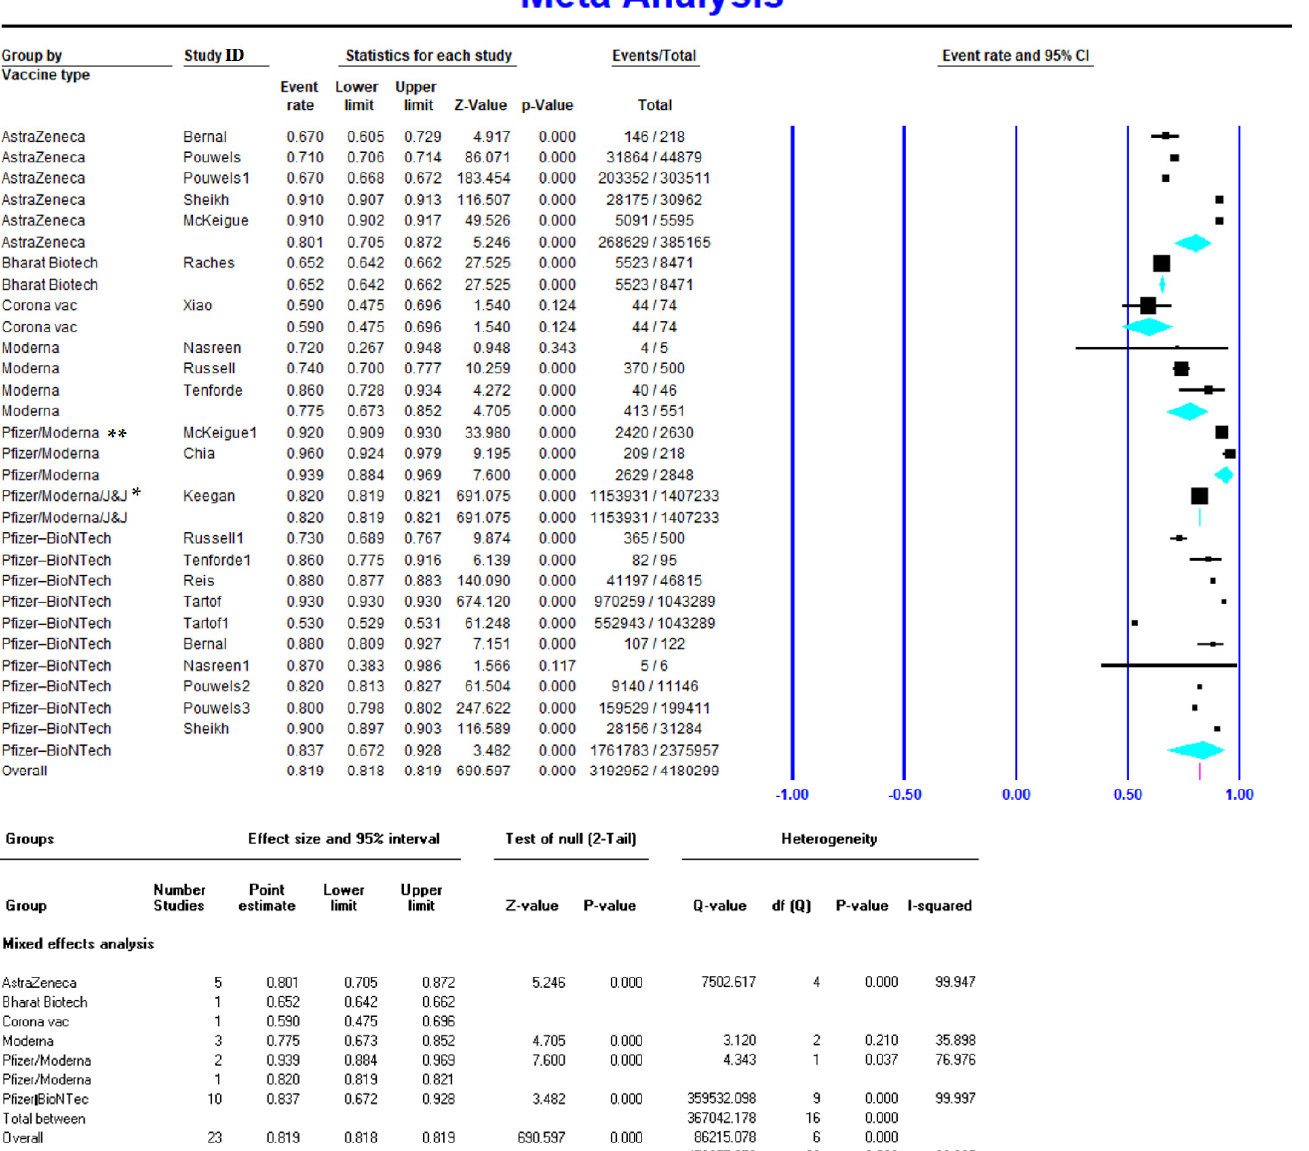
Figure 3. Effectiveness of COVID-19 vaccines after the second dose against Delta variant infection. * Reported for mRNA vaccines (Pfizer/Moderna); ** total of 52.9% included cases vaccinated with Pfizer, 38.1% with Moderna, and 9.05% with Janssen (Pfizer/Moderna/J&J).